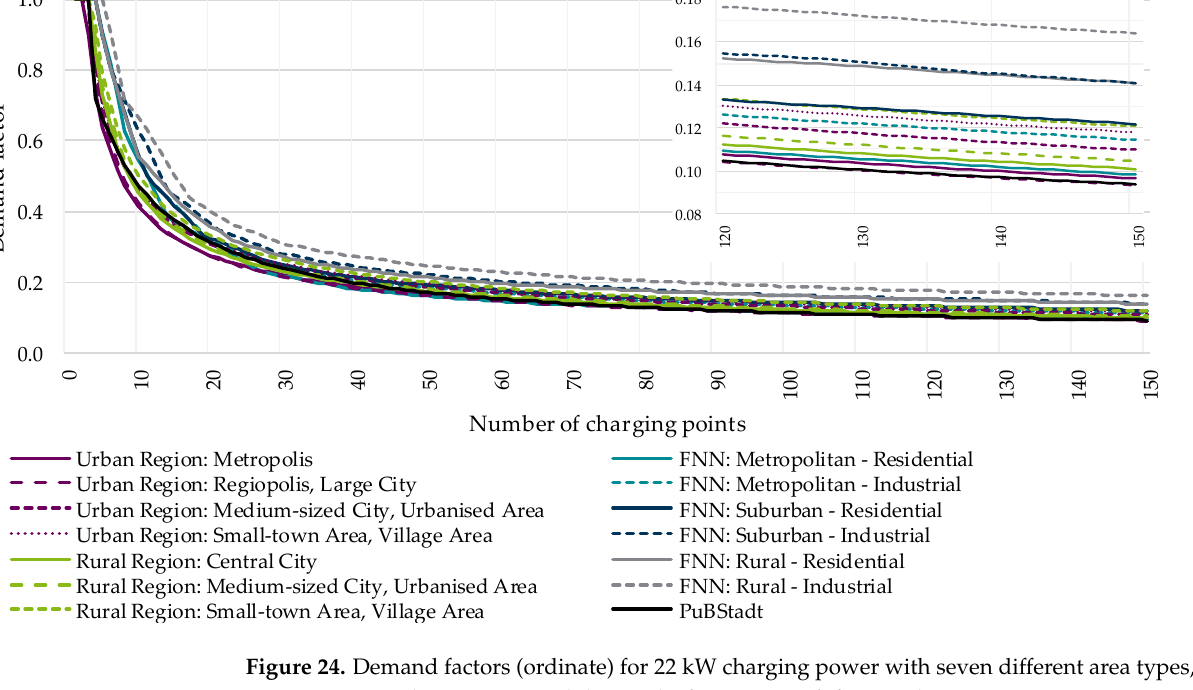
Figure 25. Demand factors (ordinate) for 11 kW charging power with seven different area types, six area types according to FNN and the results from PuBStadt for 150 charging points.